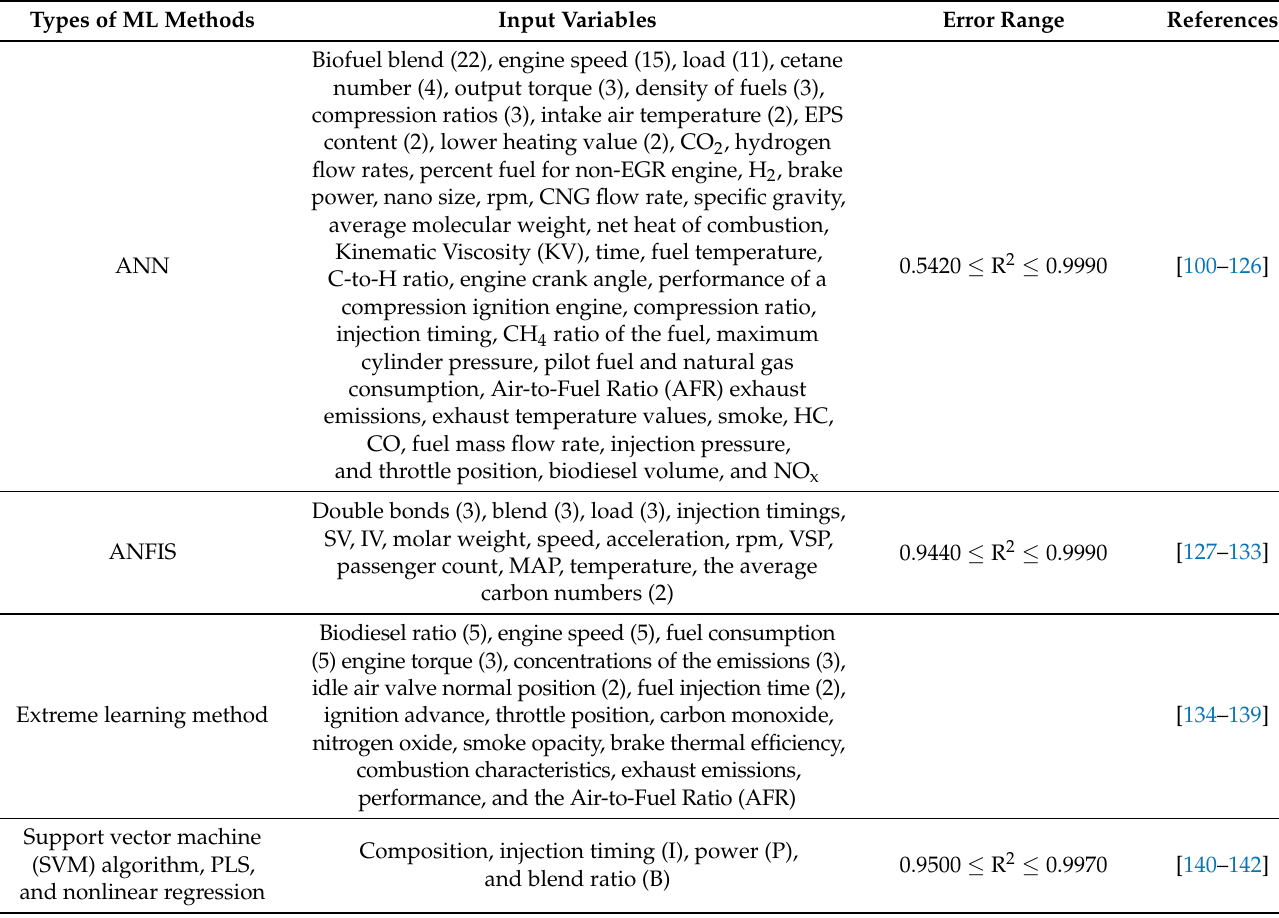
Table 5. Summary of ML applications in the consumption and emission